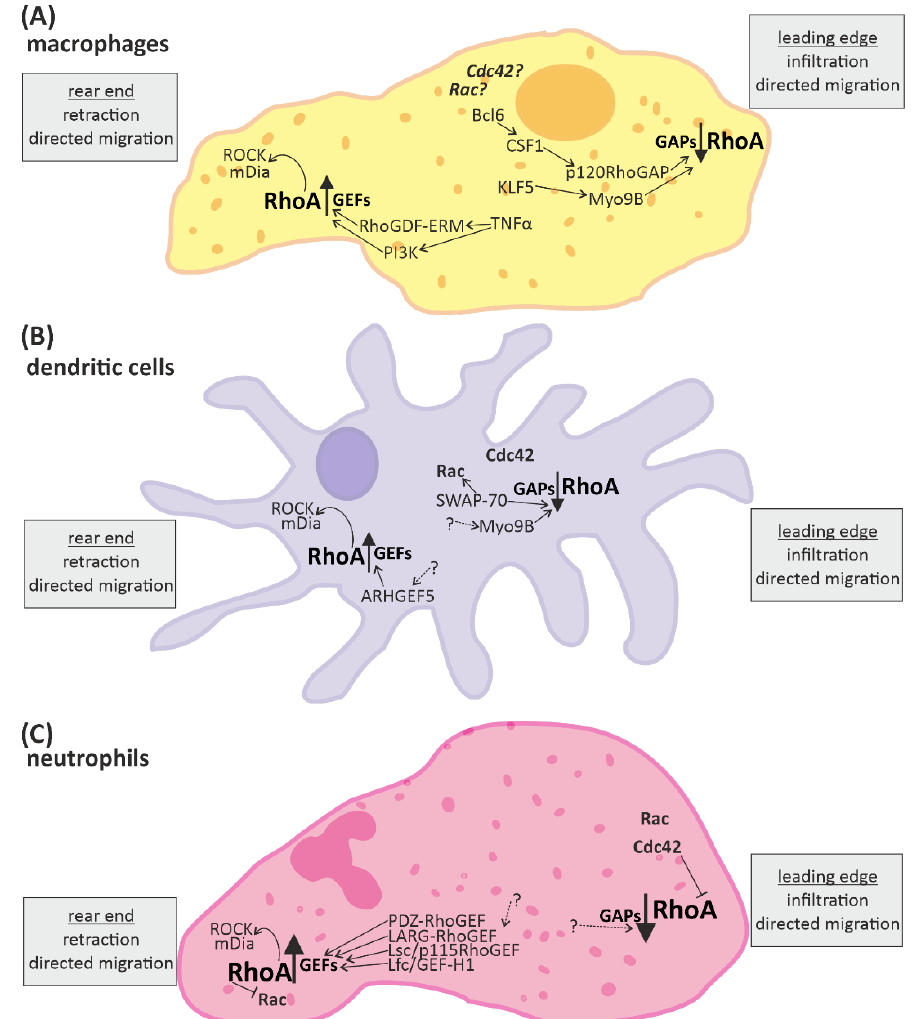
Figure 2. RhoA signaling plays an important role in cells of the innate immune system. Directed migration of macrophages, dendritic cells, and neutrophils is mediated by spatio-temporal regulated RhoA activation. In general, RhoA is activated in the rear end and reduced in the leading edge. The up-regulation of RhoA is mediated by “guanine nucleotide exchange factors” (GEFs) and leads to activation of the downstream effectors ROCK (rho-associated, coiled-coil-containing protein kinase) and mDia (diaphanous-related formin-1), which promote retraction of the rear end. RhoA- downregulation is mediated by “GTPase activating proteins” (GAPs) and facilitates infiltration or protrusion. Some signaling molecules up- and downstream of RhoA activation have been identified in different immune cells. However, many aspects of the signaling pathways are not fully known yet (indicated by dotted arrows and question marks). ( A ) In macrophages some regulators of RhoA have been identified. KLF5 (Krüppel-like factor-5) and CSF1 (macrophage colony stimulating receptor 1) activation via Bcl6 (B-cell lymphoma-6) lead to activation of the RhoA-GAPs Myo9B and p120RhoGAP, respectively, reducing RhoA activation at the front. Contrarily, the RhoGDF ERM and PI3K (phosphoinositid-3-kinase) promote the activation of RhoA at the end. ( B ) In dendritic cells the RhoA-GAP Myo9B is also located at the leading edge, attenuating RhoA activation, while the Rho-GEF5 is found in the rear end, promoting RhoA activation. Furthermore, SWAP-70 (switch- associated protein 70) was identified as a regulator of small GTPase activity. ( C ) In neutrophils a number of GEFs facilitating RhoA activation have been identified. In addition the small GTPases Rac and Cdc42 are located close to the leading edge.